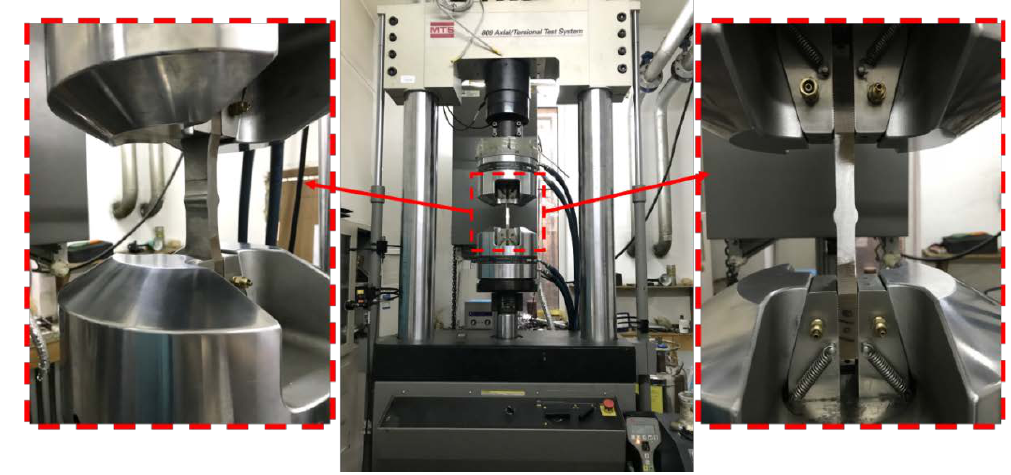
Figure 14. MTS 809 fatigue test system.